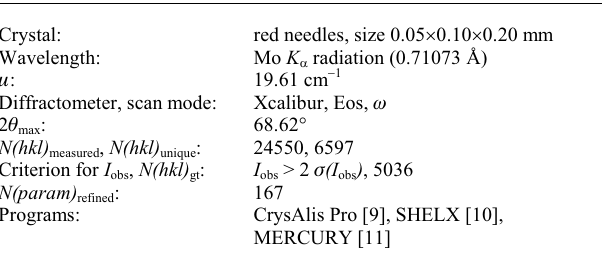
Table 1. Data collection and